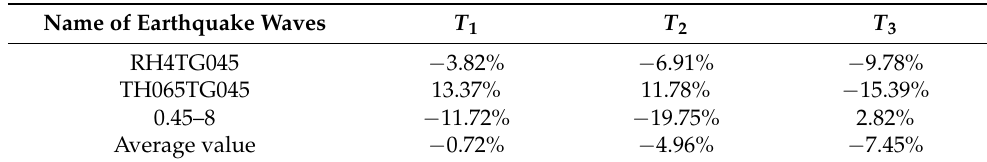
Figure 8. Response spectrum curves of the three rare earthquake waves. ( a ) RH4TG045. ( b ) Response spectrum curves of the three rare earthquake waves. TH065TG045. ( c ) 0.45–8. Table 15. Differences on the first three vibration periods between the response spectrum method and the elastic–plastic time history